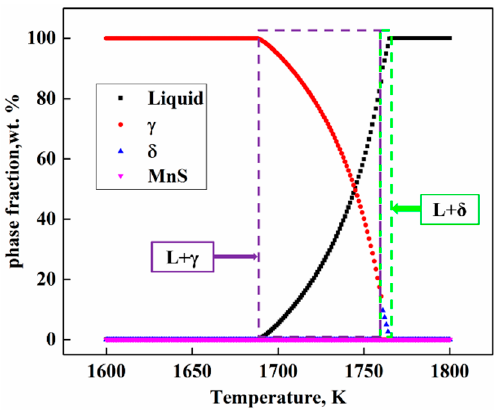
Figure 11. Phase transformation of S50C steel.